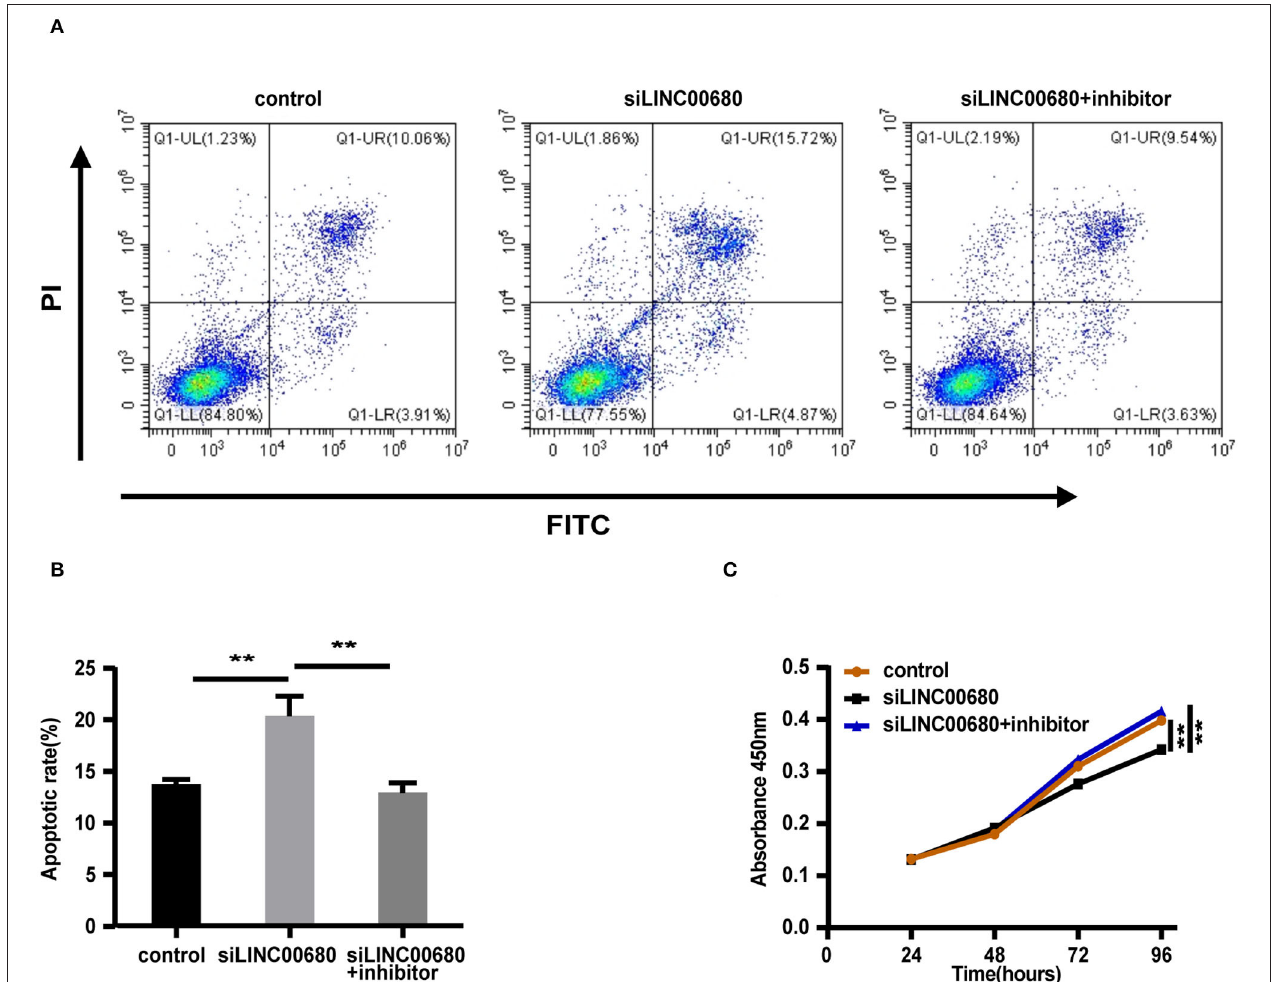
FIGURE 5 | LINC00680 inhibited apoptosis and promoted proliferation by sponging miR-320a. (A) After transfecting negative control, siLINC00680, or siLINC00680 + miR-320a inhibitor for 48h, Jurkat cells were stained with Annexin-V-FITC/propidium iodide (PI) and apoptosis was detected by flow cytometric analysis (B) The apoptosis rate of Jurkat cells after transfecting negative control, siLINC00680, or siLINC00680 + miR-320a inhibitor for 48h (C) Cell proliferation was analyzed by Cell Counting Kit-8 (CCK-8) assays after transfecting negative control, siLINC00680, or siLINC00680 + miR-320a inhibitor into Jurkat cells for 24, 48, 72, and 96h (** p <